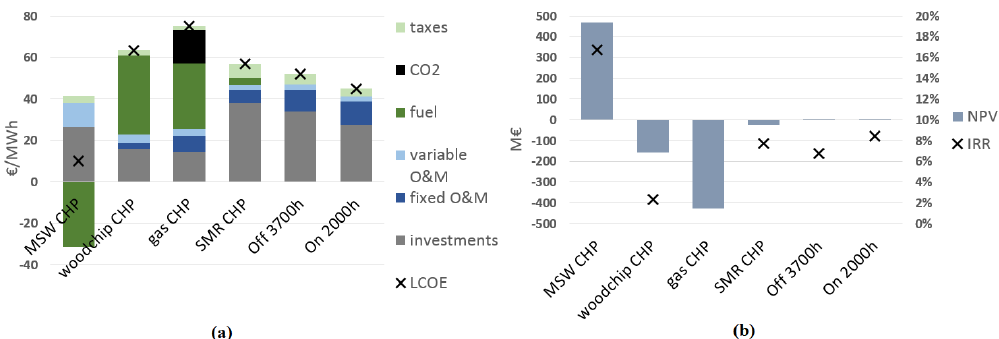
Figure 10. The LCOH breakdown ( a ) and the NPV and IRR ( b ) of HOBs and the HOB bases for CHP plants.